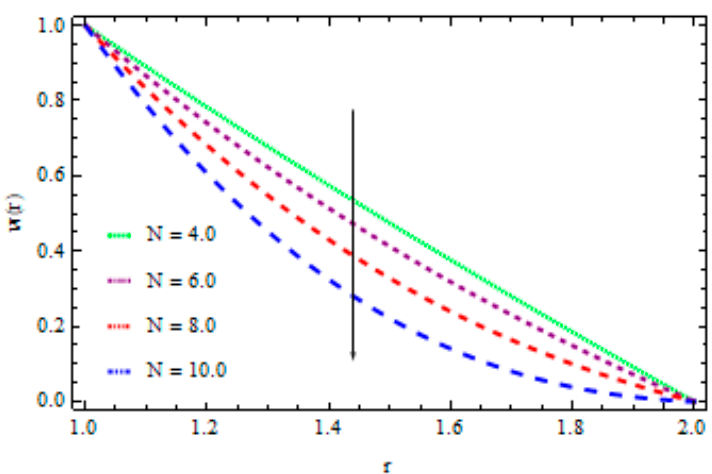
Figure 4. The influence of N on velocity distribution in case of Reynolds’ model when Q = 0.3, B r = 0.1, ε = 0.8, m = 0.13, β 0 = 1.2, K p = 0.2.